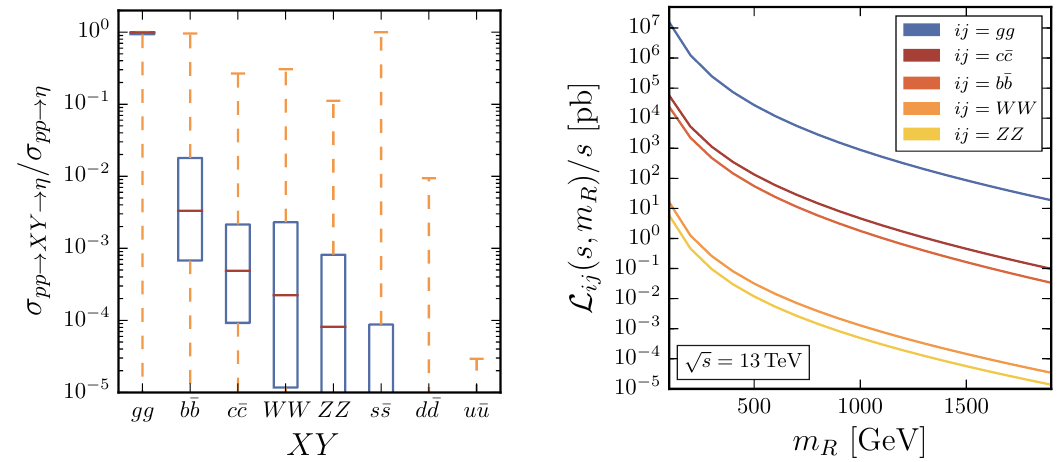
Figure 3 . Left: box plot of the (cid:17) production cross section in di(cid:11)erent channels relative to the total production cross section. For each channel we show the total range (indicated by dashed orange lines), the interquartile range (shown as a blue box) and the median (the red line inside the box) of values from viable parameter points. Right: parton luminosities for ij = gg; c (cid:22) c; b (cid:22) b and e(cid:11)ective parton luminosities from EWA for ij = WW; ZZ . We use p s = 13